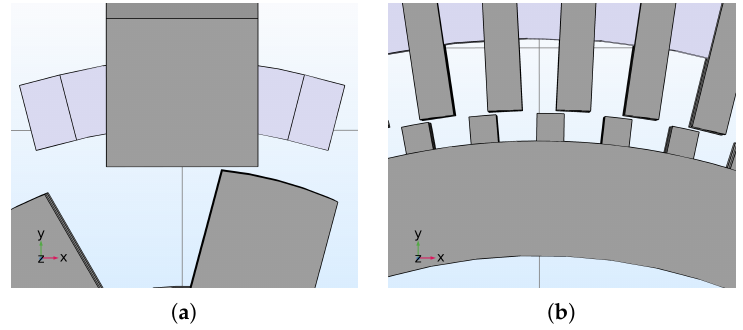
Figure 11. Zoomed view of the air-gap of the HM3D machine; ( a ) original and ( b ) with n seg = 8. Table 1. Calculated values of main parameters of an HM3D machine with n seg = 1, 2, 4, and 8.